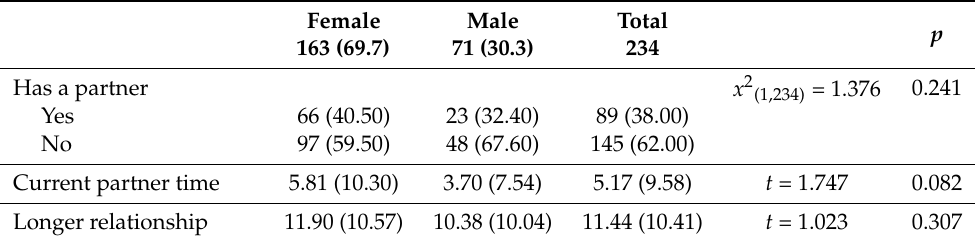
Table 1. Characteristics of couple relationships according to the gender of the